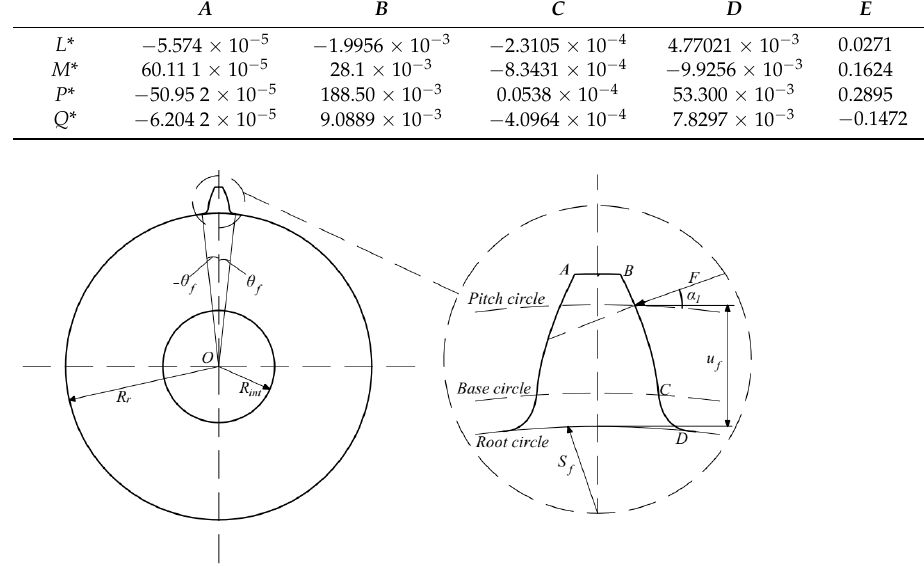
Figure 2. Geometric parameters of fillet foundation deflection.